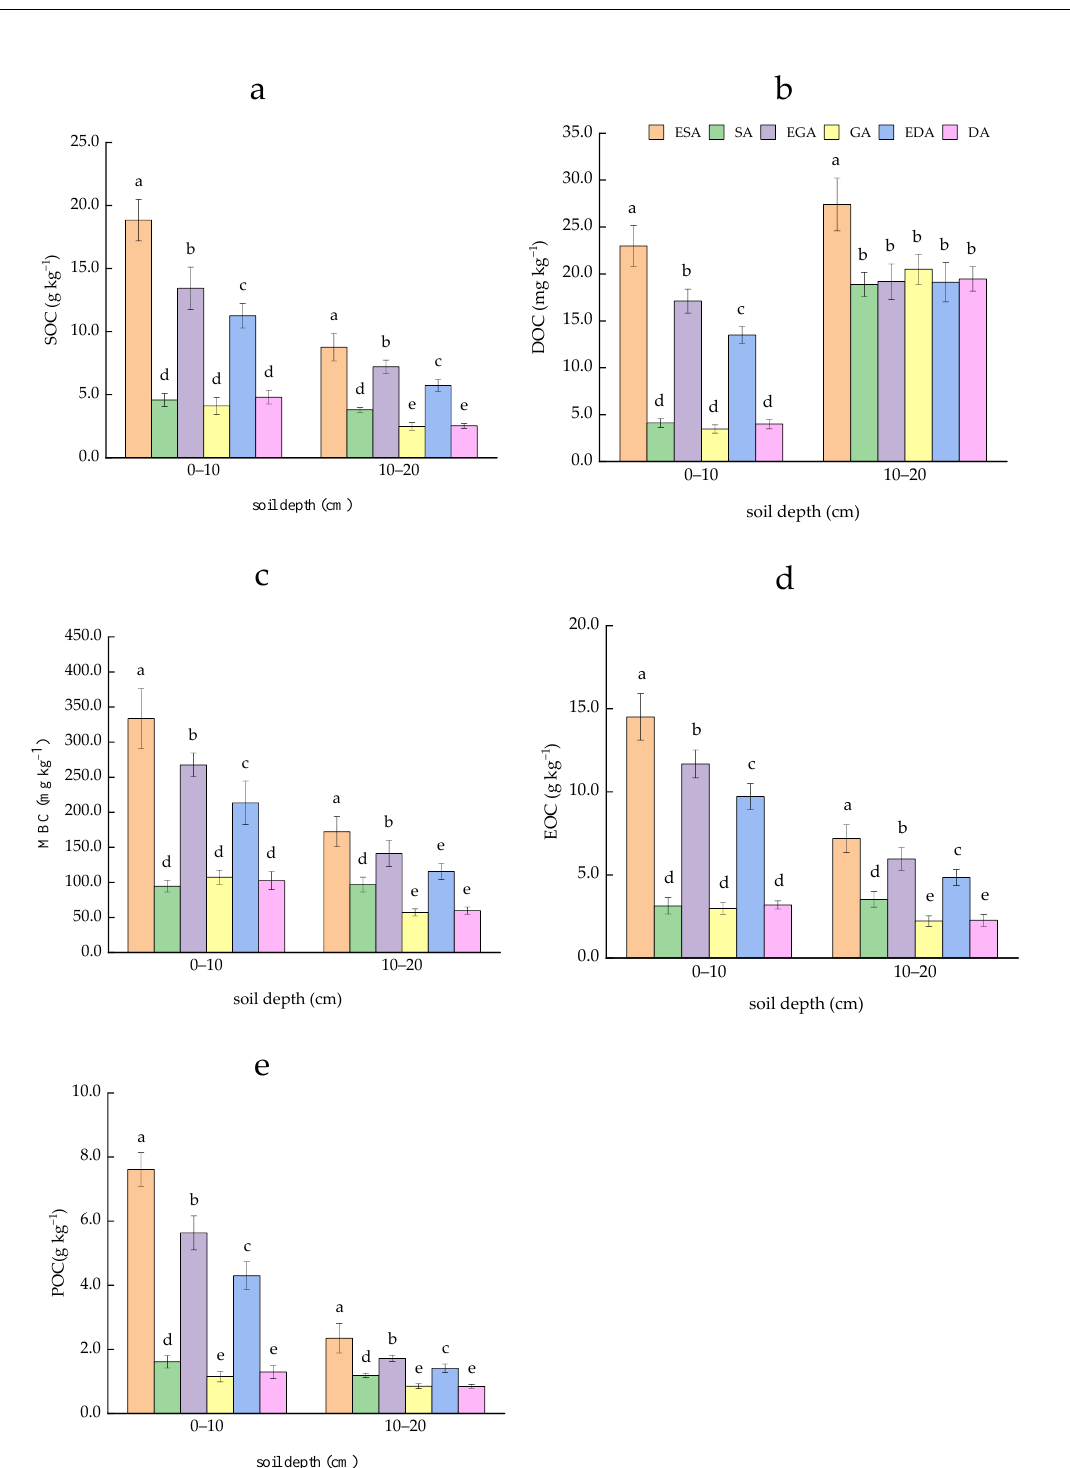
Figure 1. SOC and its fractions in different vegetation types. ( a ) SOC, soil organic carbon; ( b ) DOC, dissolved organic carbon; ( c ) MBC, Microbial biomass carbon; ( d ) EOC, Easily oxidized organic carbon; ( e ) POC, Particulate organic carbon. Different lowercase letters indicate significant differences between different forest types ( p < 0.05).